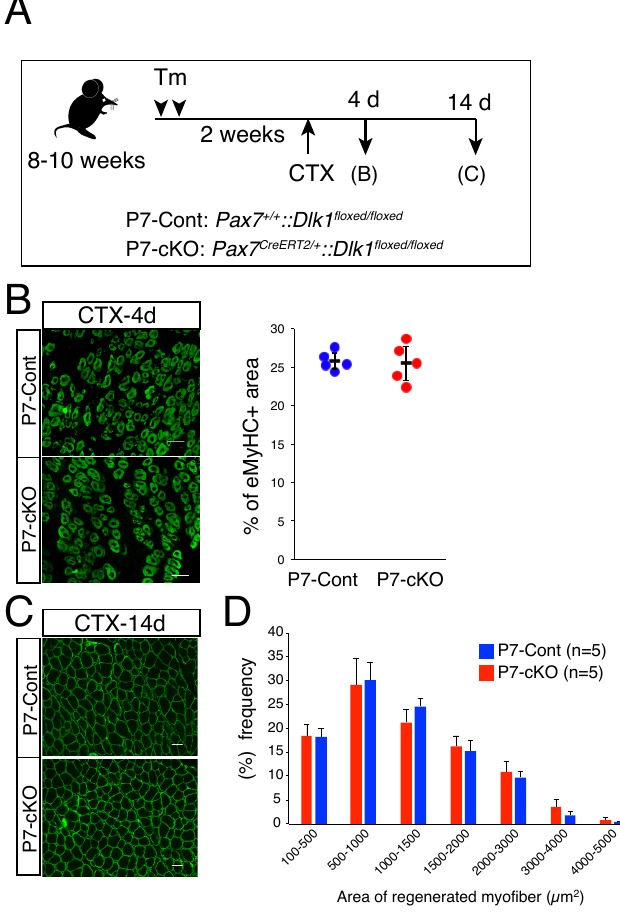
Figure 1. Role of Dlk1 in myogenic lineage cells. ( A ) Cardiotoxin (CTX) and tamoxifen (Tm) time scheme for analysis of the regenerative potential of P7-control and P7-cKO mice. ( B ) Immunostaining of embryonic myosin heavy chain (eMyHC, green) in injured TA muscle 4 days after CTX injection. The y-axis shows the eMyHC + area (percentage) in P7-control (blue circle, n = 5) and P7-cKO (red circle, n = 5) mice. Error bars indicate the mean with SD. Scale bar: 50 µ m. ( C ) Immunostaining of laminin α 2 (green) in P7-control and P7-cKO regenerated TA muscle 14 days after CTX injection. Scale bar: 50 µ m. ( D ) Graphs indicate the quantitative analyses of the myofiber areas in P7-control (blue bar) and P7-cKO (red bar) mice. The y-axis represents the percentage of each myofiber size range. The x-axis indicates the size of the myofibers. Data show the average of five mice per group from two independent experiments with